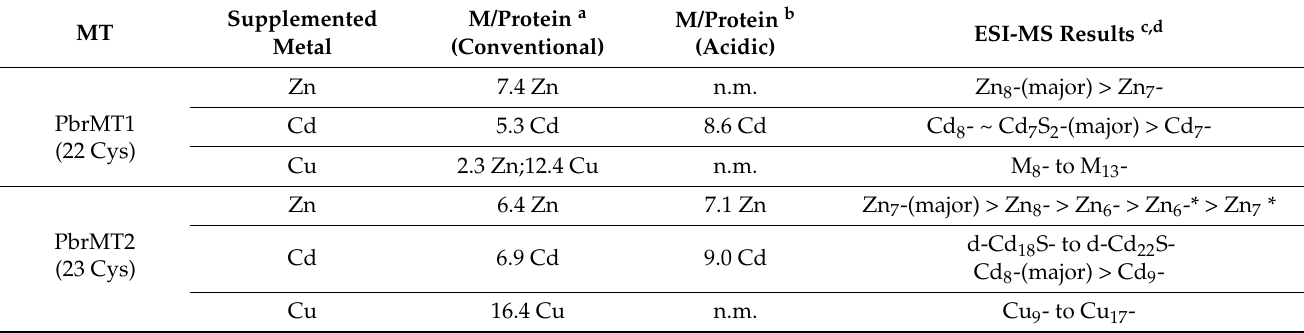
Table 1. Metal-to-protein ratios found by ICP-AES in the recombinantly produced Zn(II)-, Cd(II)- and Cu(I)-PbrMT1 and